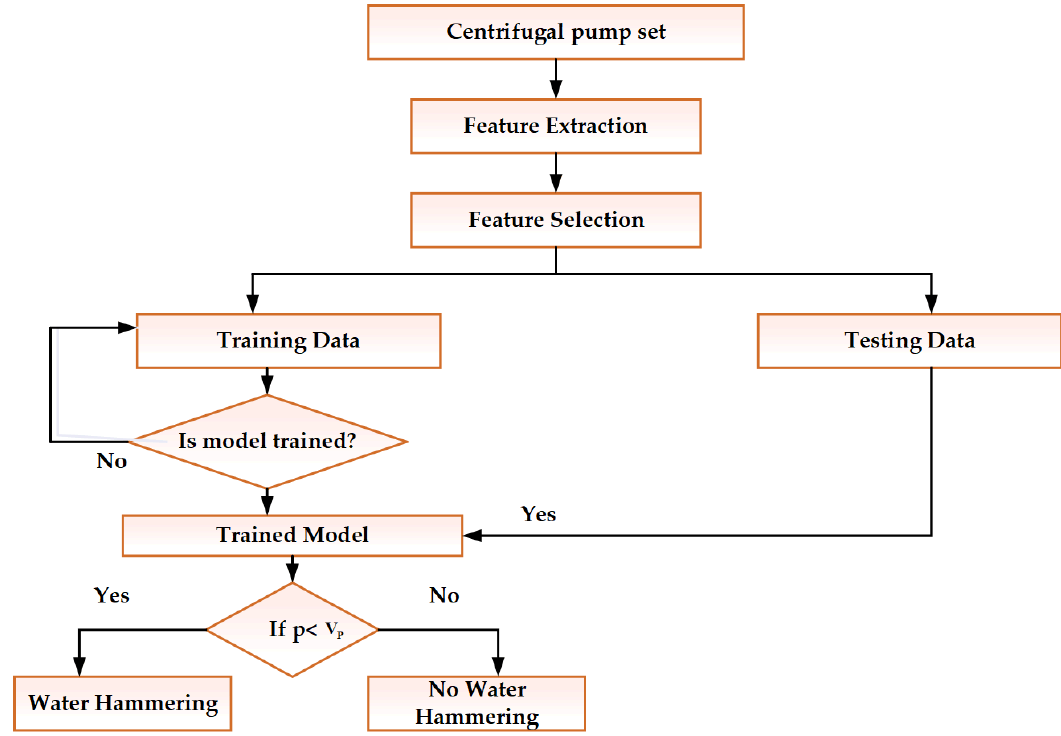
Figure 2. Generalized algorithm of water hammering.